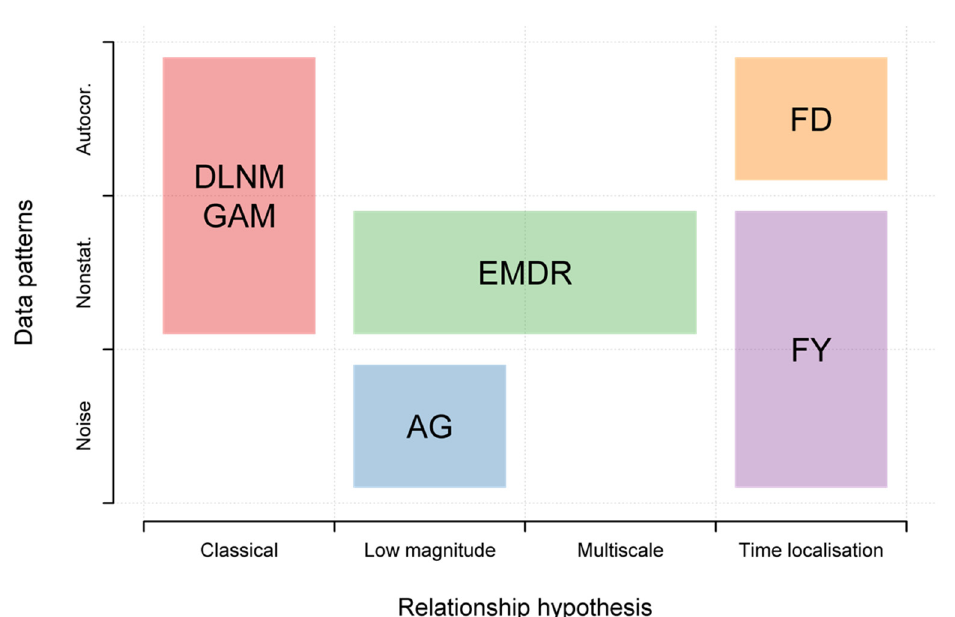
Figure 6. Summary of the cases of interest for each strategy. The abscissa indicates the scale corre- sponding to the objective of the study and the ordinate to the issues potentially present in the data. DLNM, distributed lag nonlinear model; GAM, generalized additive model; AG, aggregation of response; EMDR, EMD-regression; FD, functional with daily curves; FY, functional at the yearly